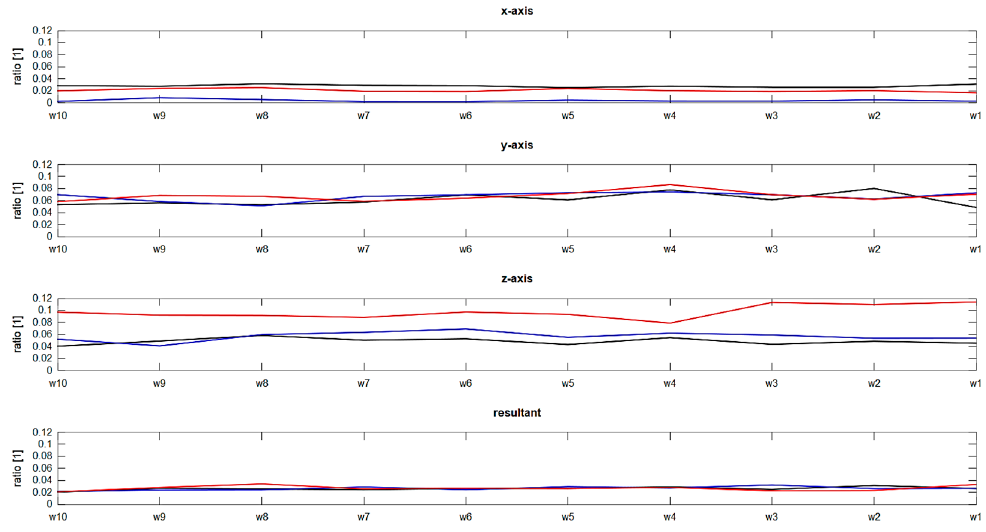
Figure 6. Median values of the CV for the three axes and the resultant acceleration of the string arm. Every graph contains the values for C1 (black), C2 (blue) and C3